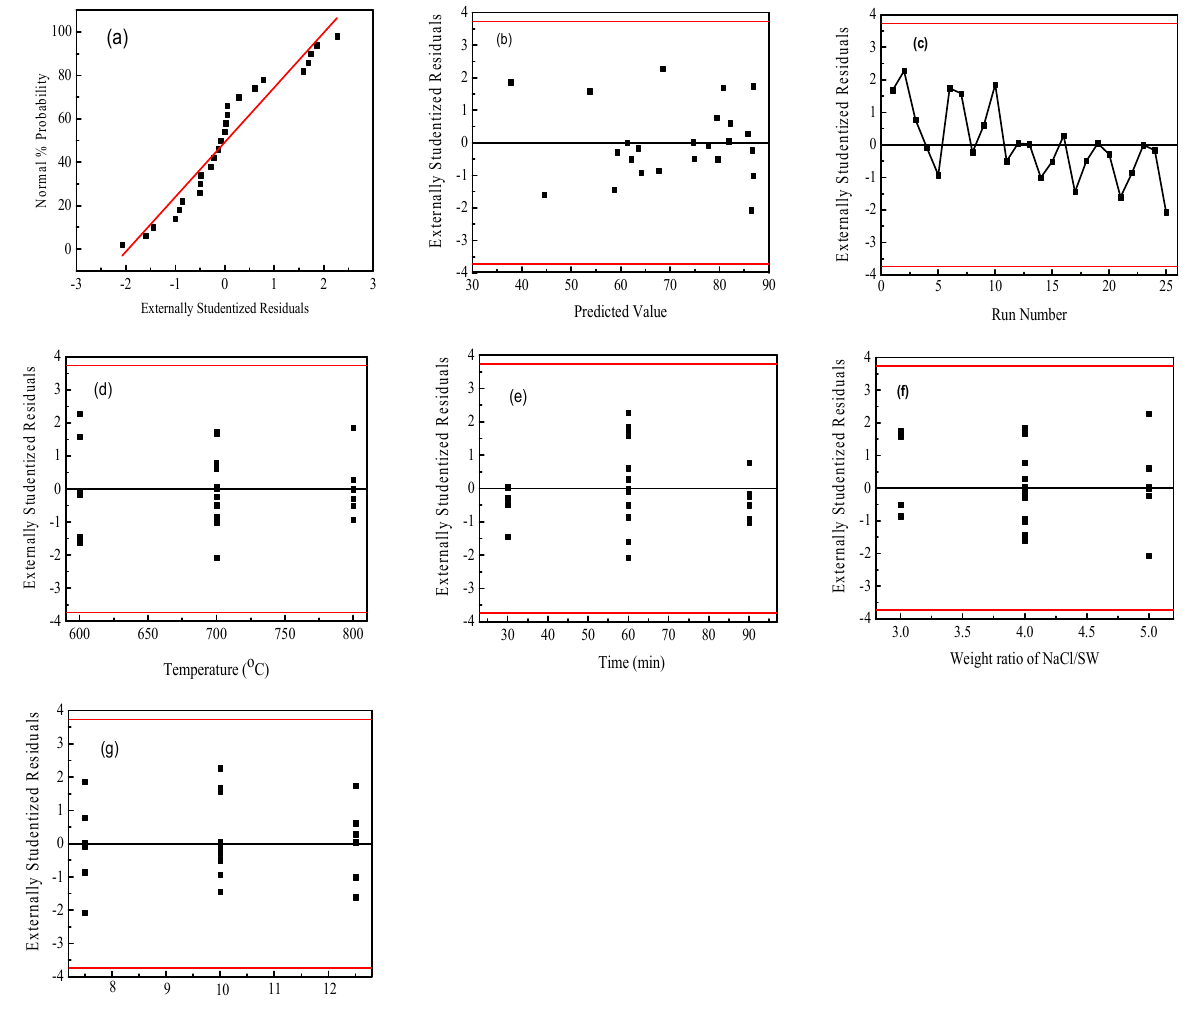
Figure 3. The statistical properties of the obtained capacitance values from Box–Behnken design using Design Expert software. ( a ) the normal probability plot of the residuals; ( b ) the scatter analysis of residuals versus predicted values; ( c ) the distribution of the residuals; ( d – g ) the residual independence examination of each factor regression model. Note: The red line in ( a ) represents the least square fitting line and ( b – g ) the confidence interval of the data, respectively. Table 5. The optimal preparatory conditions after software analysis.